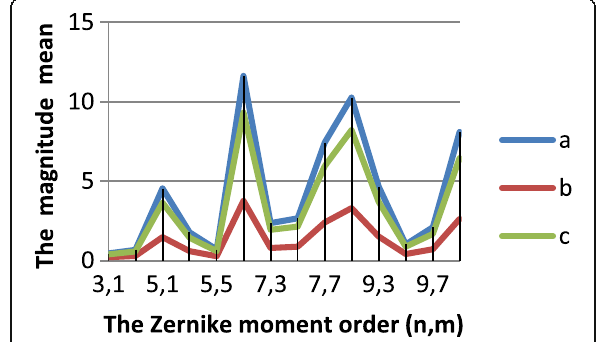
Fig. 3 Evaluation for different orders ( n , m